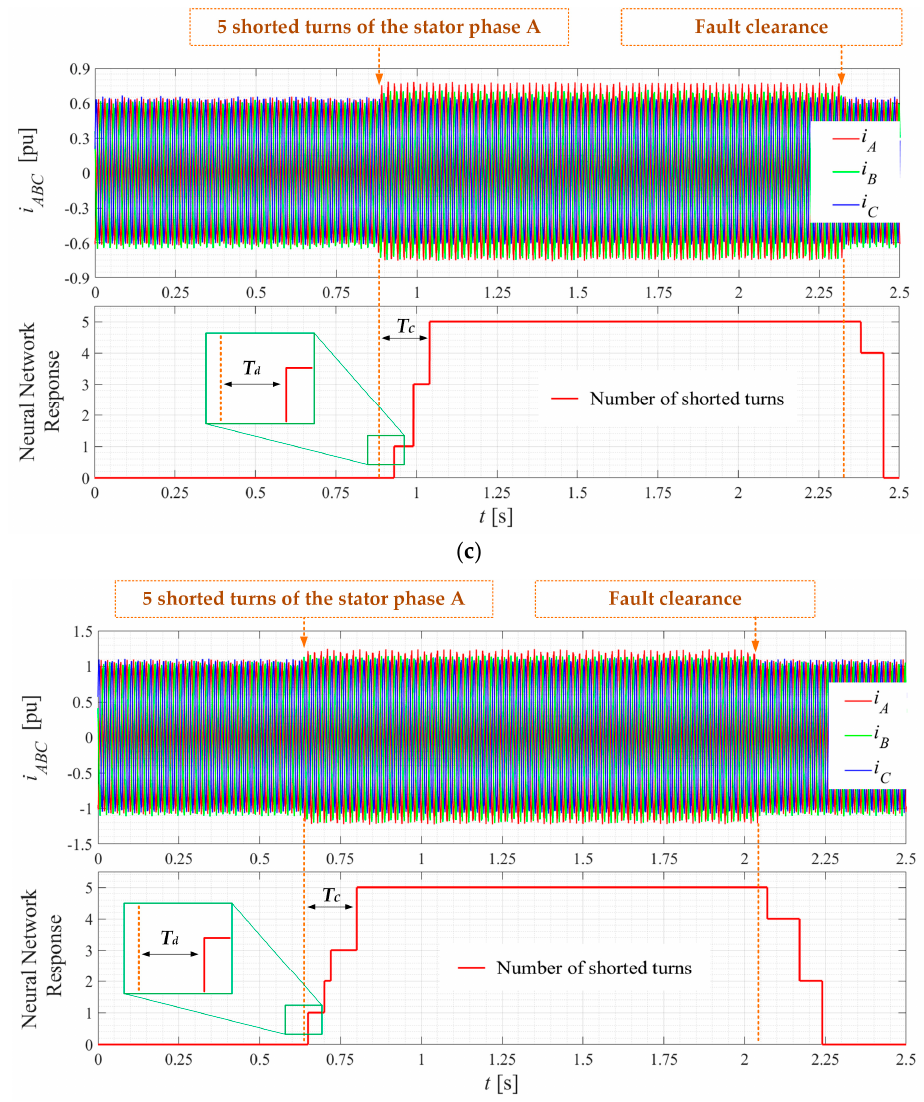
Figure 4. CNN on-line response during motor operation: ( a ) N sh = 5, f s = 20 Hz, T L = 0.2 T N , T d = 0.0273 s, T c = 0.1783 s; ( b ) N sh = 5, f s = 20 Hz, T L = 0.6 T N , T d = 0.0085 s, T c = 0.1985 s; ( c ) N sh = 5, f s = 50 Hz, T L = 0.4 T N , T d = 0.0508 s, T c = 0.1503 s; ( d ) N sh = 5, f s = 50 Hz, T L = 0.8 T N , T d = 0.022 s, T c = 0.1536 s: N sh —number of shorted turns in stator windings; T N —nominal torque; T L —load torque; f s —supply voltage frequency; T d —fault detection time; T c —fault classification